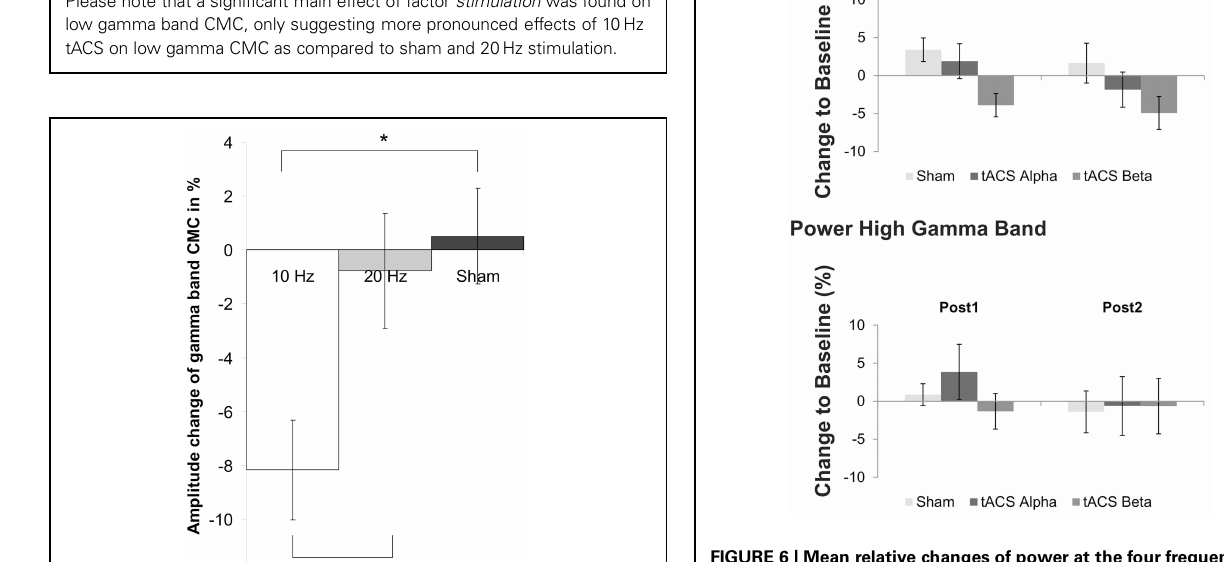
FIGURE 6 | Mean relative changes of power at the four frequency bands of interest following 10Hz, 20Hz and sham tACS. Error bars indicate standard error of mean. Please note that a trend toward a significant main effect of factor stimulation was found on low gamma band power, only. Post-hoc analysis revealed that low gamma band power following 20Hz tACS was significantly reduced as compared to sham stimulation and 10Hz